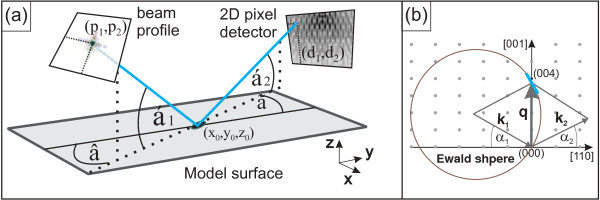
Sketch of the geometrical situation and variable definitions.p1,p2are the beam profile pixel coordinates; α1and α2are the beam incidence and exit angles with related azimuth angles βand γ. d1,d2are the detector pixel coordinates, and r0=(x0), y0, z0) is the reference point of the spot center at the sample surface (a). A 2D sketch of the situation in reciprocal space for the (004) reflection is shown in (b). Therein, k1, k2are the wave vectors, q is the scattering vector, and the 2D detector (blue line) stands orthogonally to the sketch (which is the [11¯0] direction).